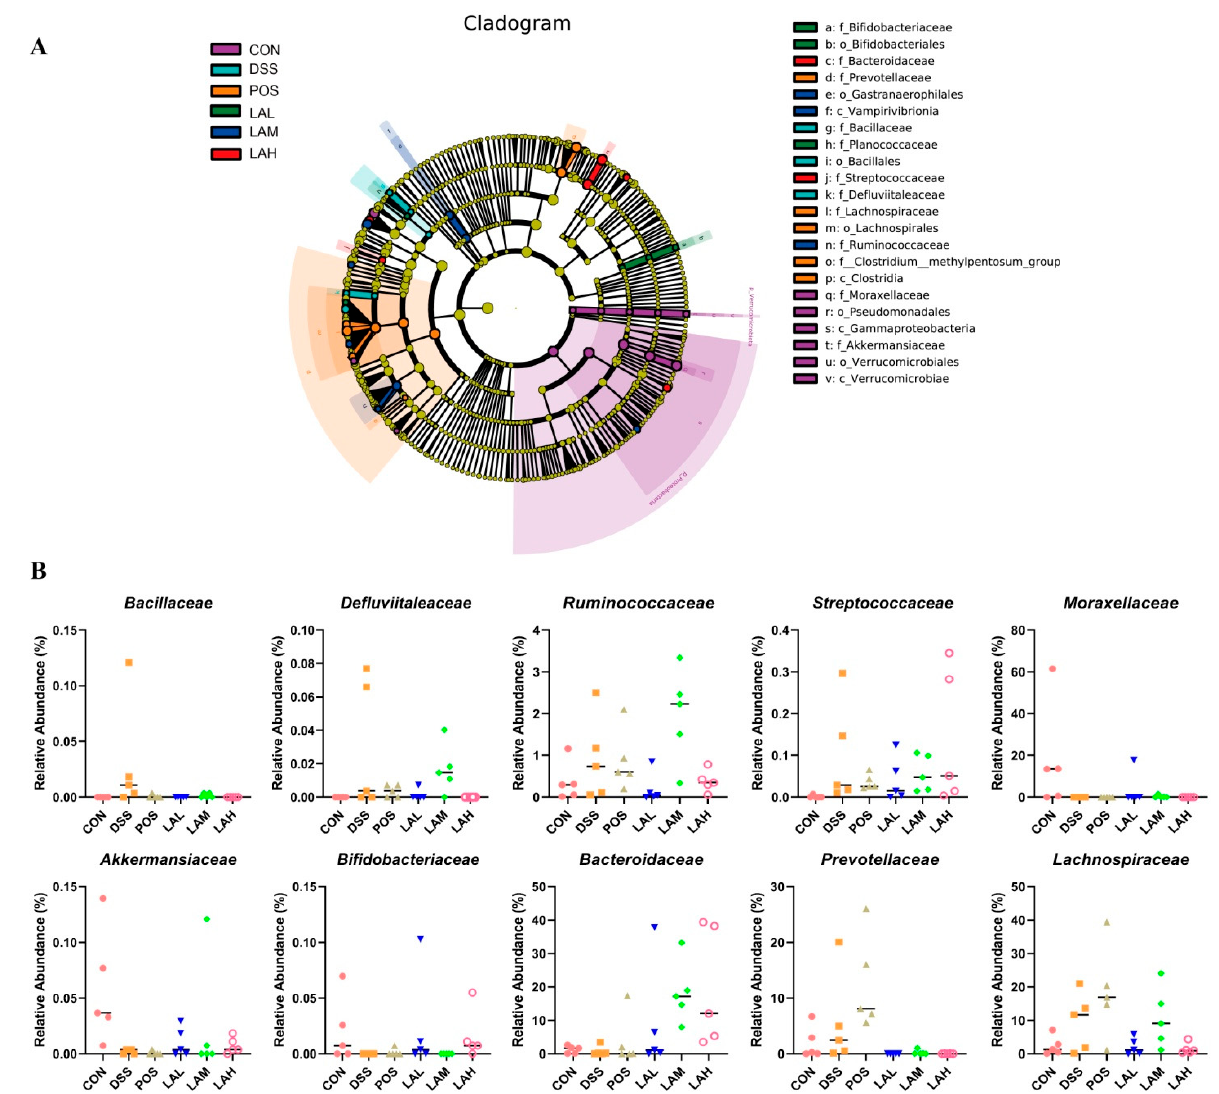
Figure 4. Biomarkers in six groups. ( A ) Cladogram of linear discriminant analysis effect size (LEfSe) comparison analysis. ( B ) Relative abundances of families that were significantly modulated by LA and SASP. Data are expressed as mean ± SD ( n = 5).